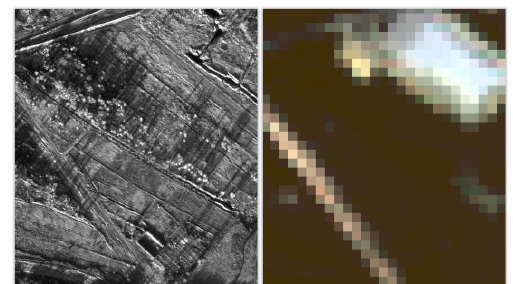
Figure 3. Open area. Left image: panchromatic imagery from Eros. Right image: multispectral imagery from Landsat-8 in the band combination 4 (red), 3 (green), 2 (blue) A characteristic feature of the test data is very high ratio between spatial resolution of the two imagery from Landsat and EROS B. What is more, the images from both satellites are difficult in the interpretation.